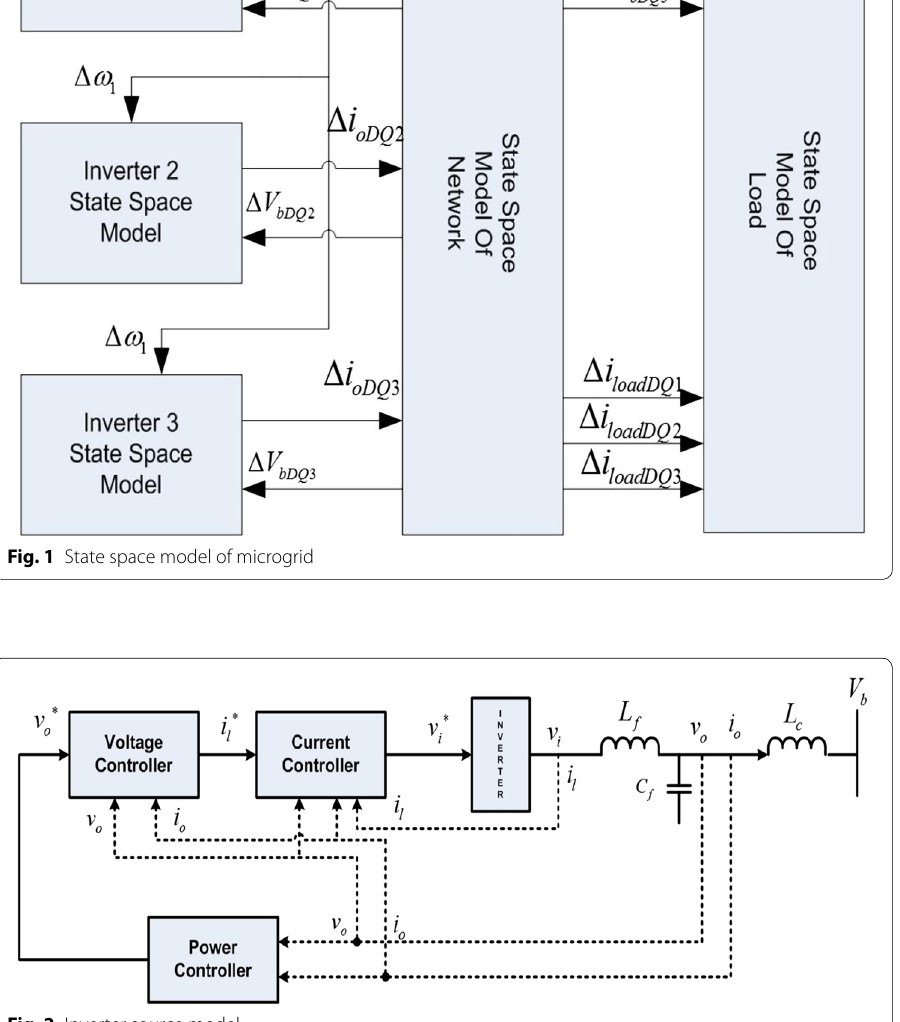
Fig. 2 Inverter source